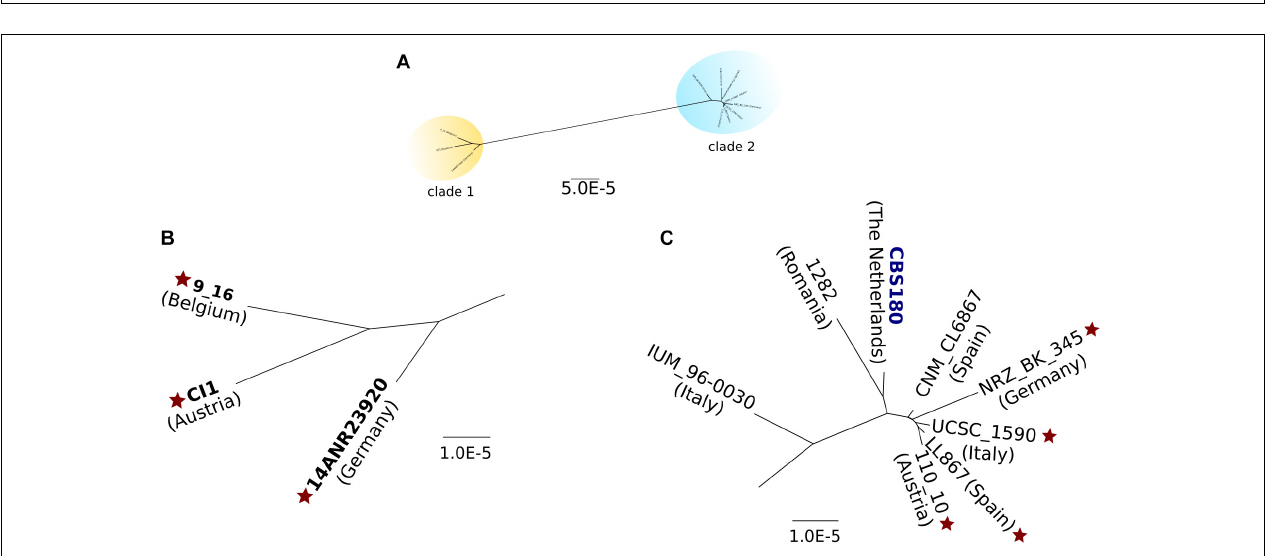
FIGURE 2 | Frequency of heterozygous variants per kilo-base in CBS180 heterozygous blocks. The distribution of this frequency is close to normal, with a peak at 30 variants/kb, consistently with the estimated current parental divergence.